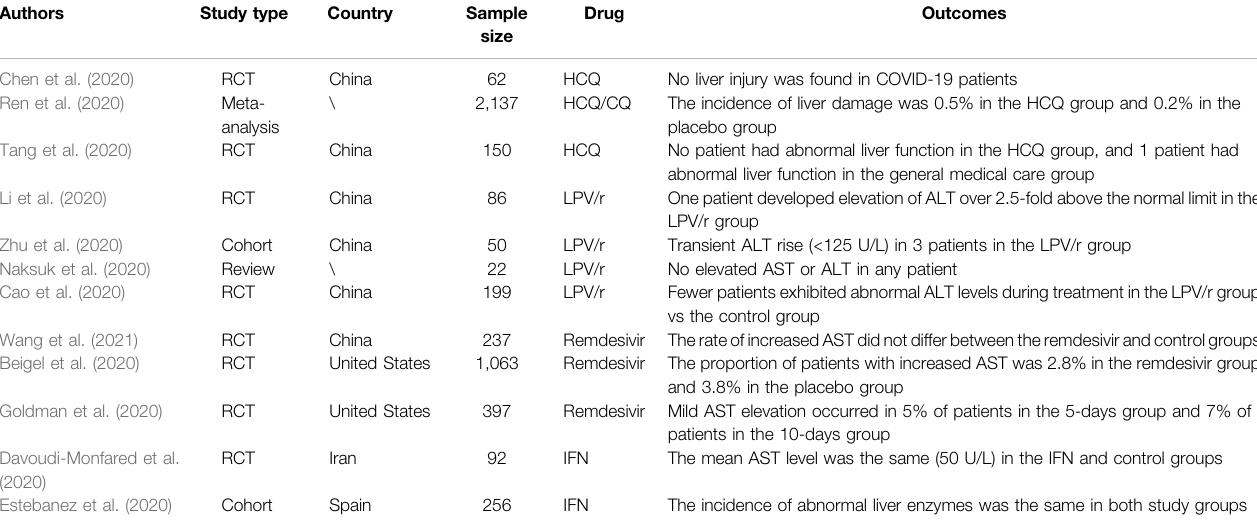
TABLE 1 | Characteristics of the included studies.